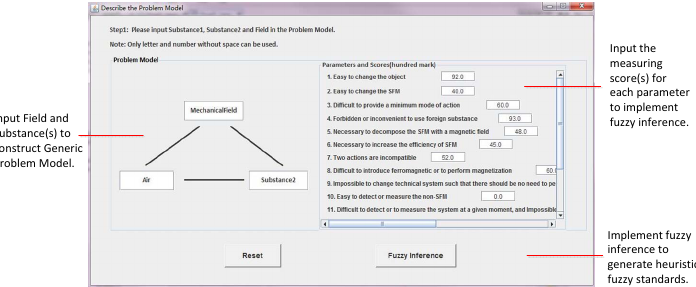
Figure 7. Describe the Problem Model for the case of the “Auguste Piccard’s Stratostat”.